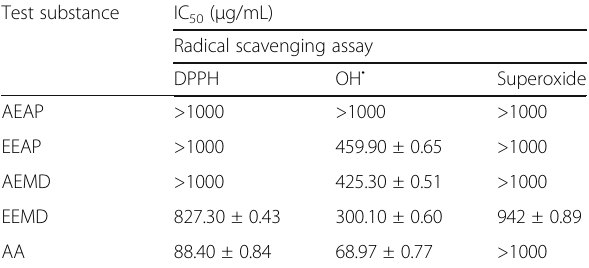
(EEAP and EEMD), as compared with their aqueous ex- tracts, are found similar to standard ascorbic acid at the tested amount of 1000 μ g/mL (Fig. 1b and Additional file 1: Table S2). Both EEAP and EEMD showed scaven- ging activity that is comparable with standard ascorbic acid against hydroxyl free radicals as compared with DPPH free radicals. Further, EEAP showed scavenging Table 3 IC 50 Free radical scavenging activity of prepared plant leaf extracts Test